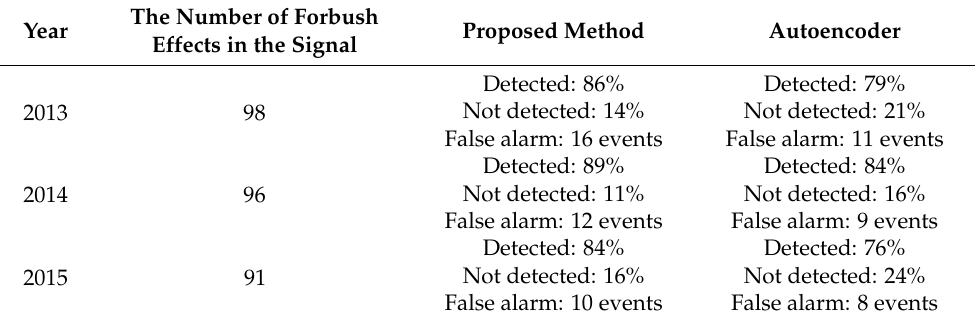
Table 4. Estimation of the efficiency of the proposed